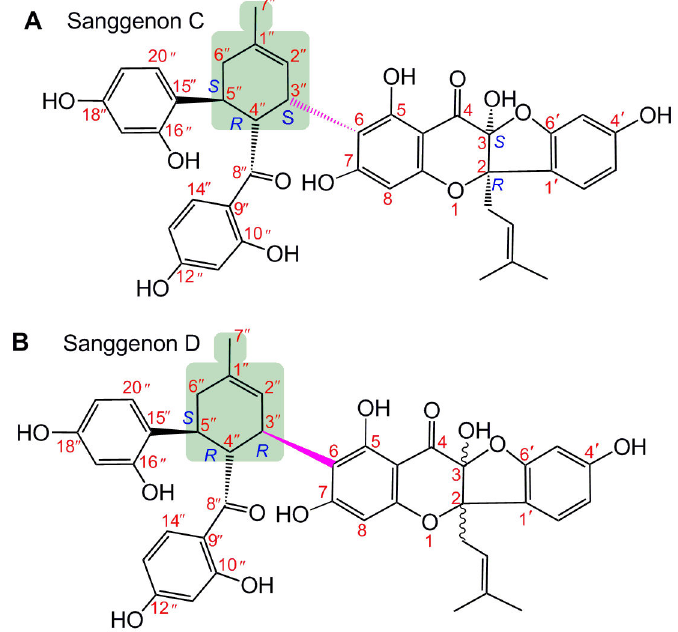
Figure 1. The structures of sanggenons C ( A ) and sanggenons D ( B ) (the Diels-Alder-type adduct skeletons are in light